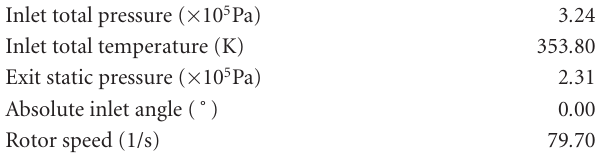
Table 2: Boundary conditions.